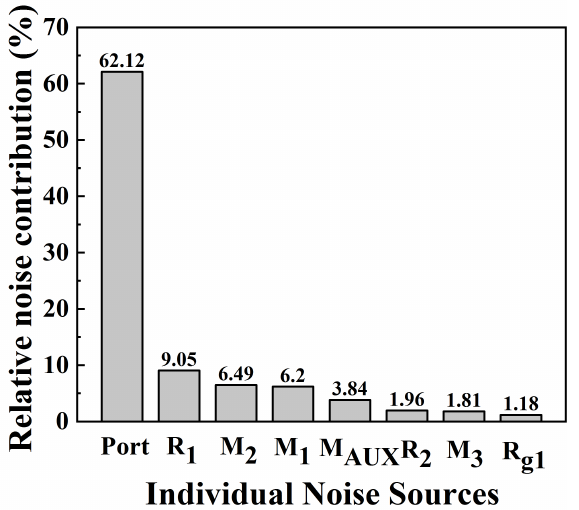
Figure 6. Simulated noise contributions by individual components in proposed